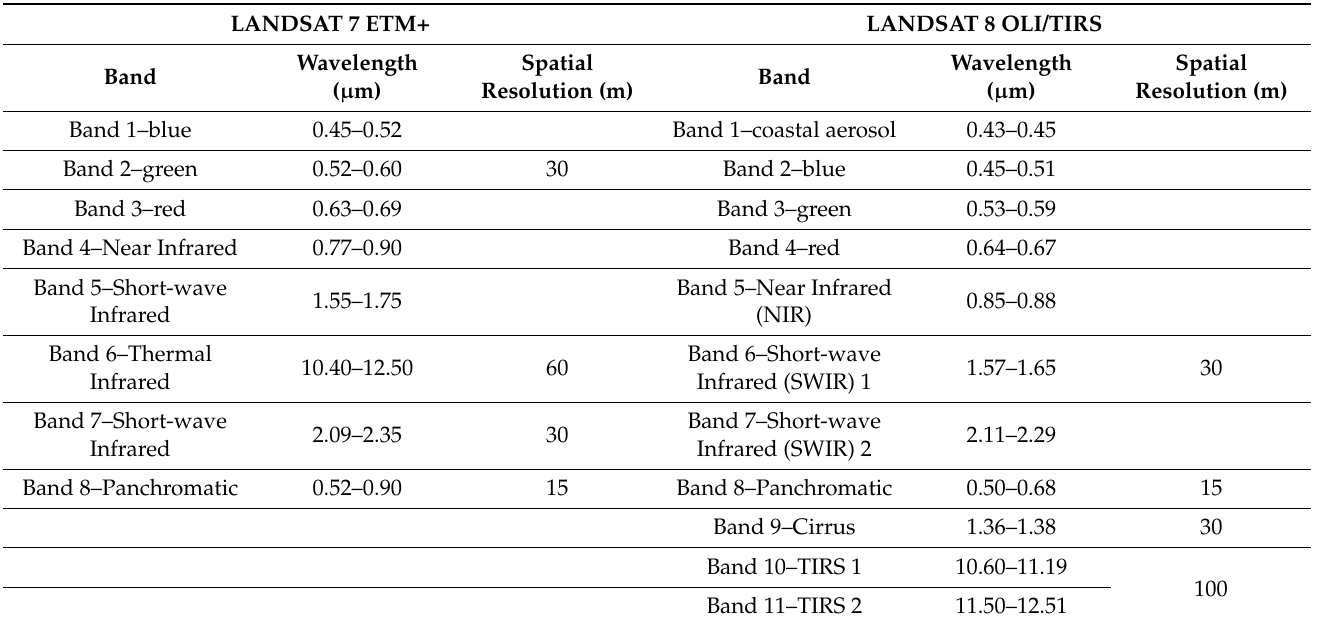
Table 1. Spatial and spectral characteristics for LANDSAT 7 ETM+ and LANDSAT 8 OLI/TIRS